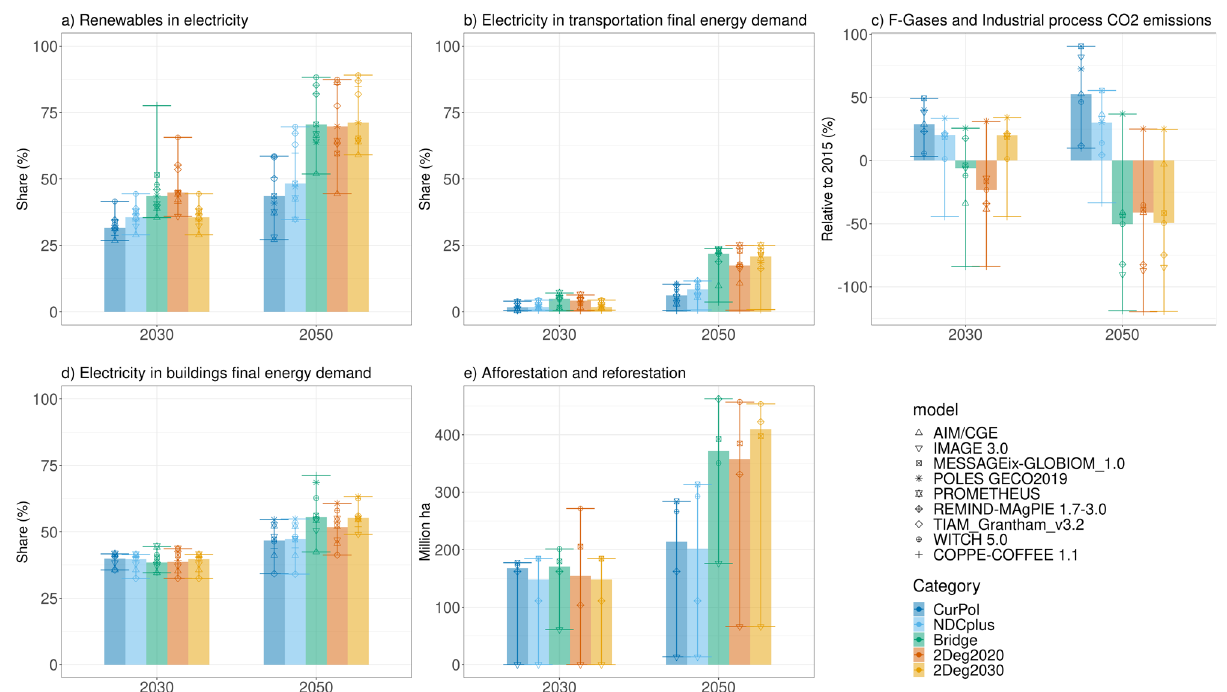
Fig. 3 Projected changes in various indicators, for 2030 and 2050, for the CurPol, NDCplus, Bridge, 2Deg2020, and 2Deg2030 scenarios. Bars show model median, error bars show the full range, and symbols show individual model results. Panel a share of renewables in electricity production (%), panel b share of electricity in fi nal energy demand of transportation (%), panel c Emissions of F-gases and industrial process CO 2 emissions, relative to 2015 levels (%), panel d share of electricity in fi nal energy demand of buildings (%), panel e total afforestation and reforestation (million